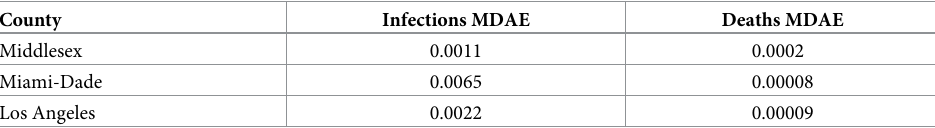
Table 5. MDAE for model conditioned on infection and death statistics. Note that MDAE is scaled relative to the population of a given county; since death counts are smaller, a model with the same relative quality achieves lower absolute